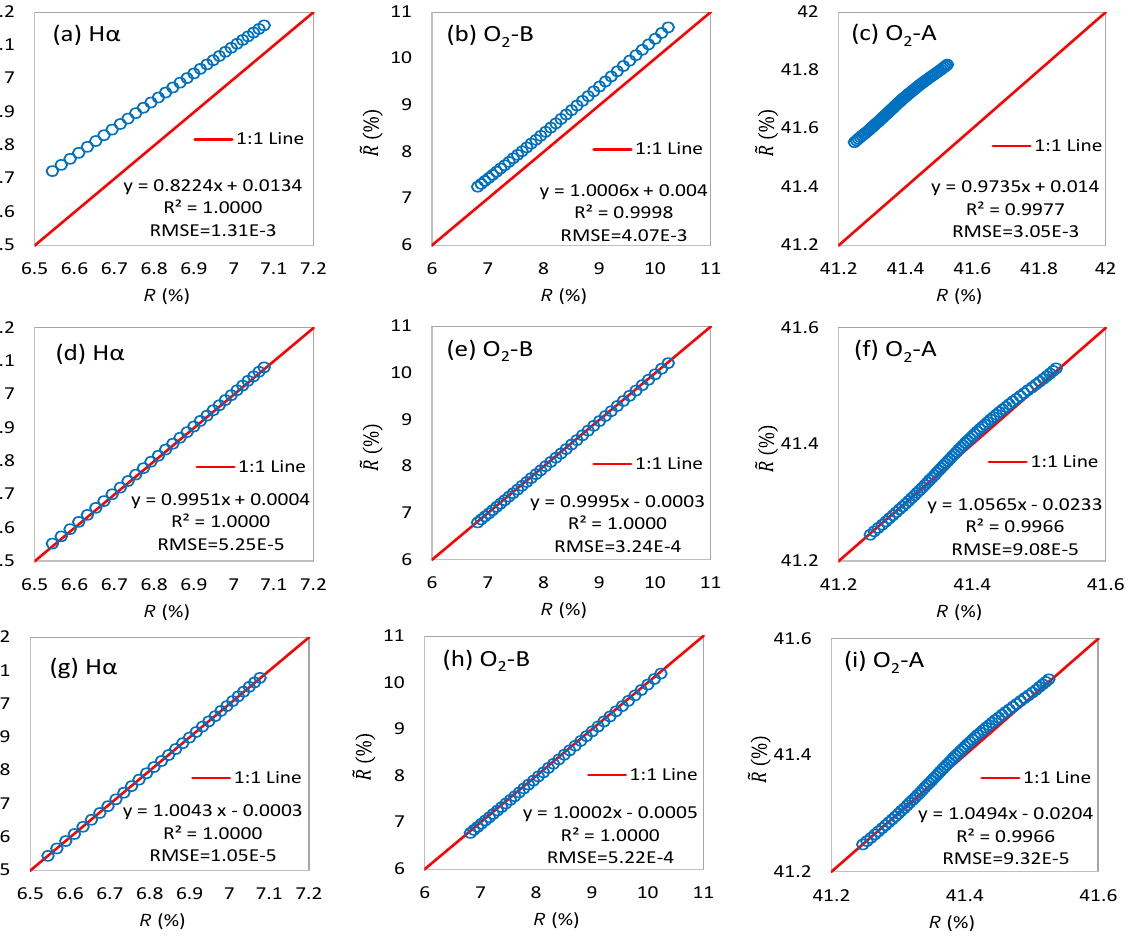
Figure 3. The correlation between the true reflectance ( R ( λ )) and the reconstructed reflectance ( ( ) R  ) for the first three iterations (( a–c ), ( d–f ), and ( g–i )) at the Hα ( left ), O 2 -B ( middle ), and O 2 -A ( right ) bands. The values of the coefficient of determination (R 2 ) and RMSE are also given in each